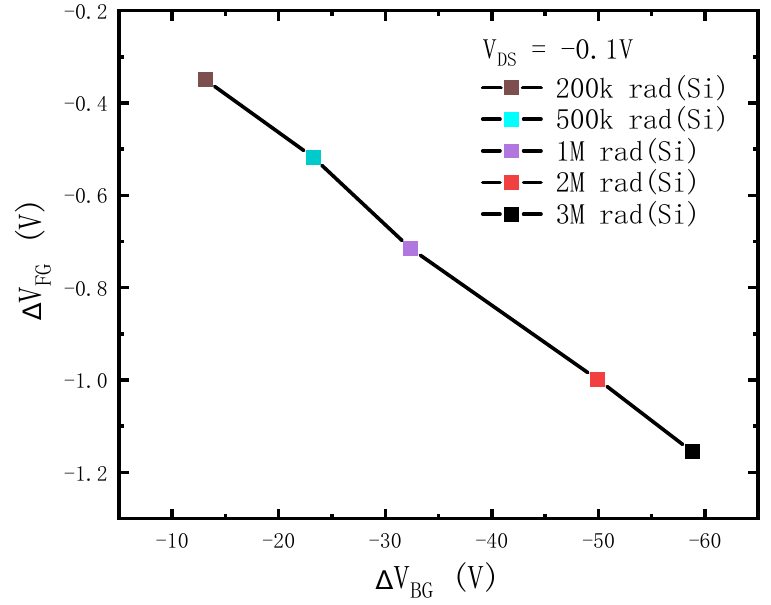
Figure 8. Changes of coupling coefficient.